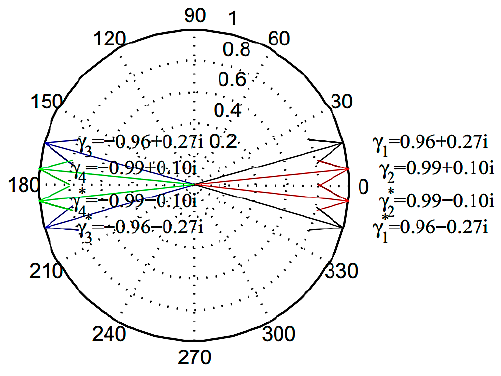
Figure 7. The poles of noise-free simulation model in complex plane.